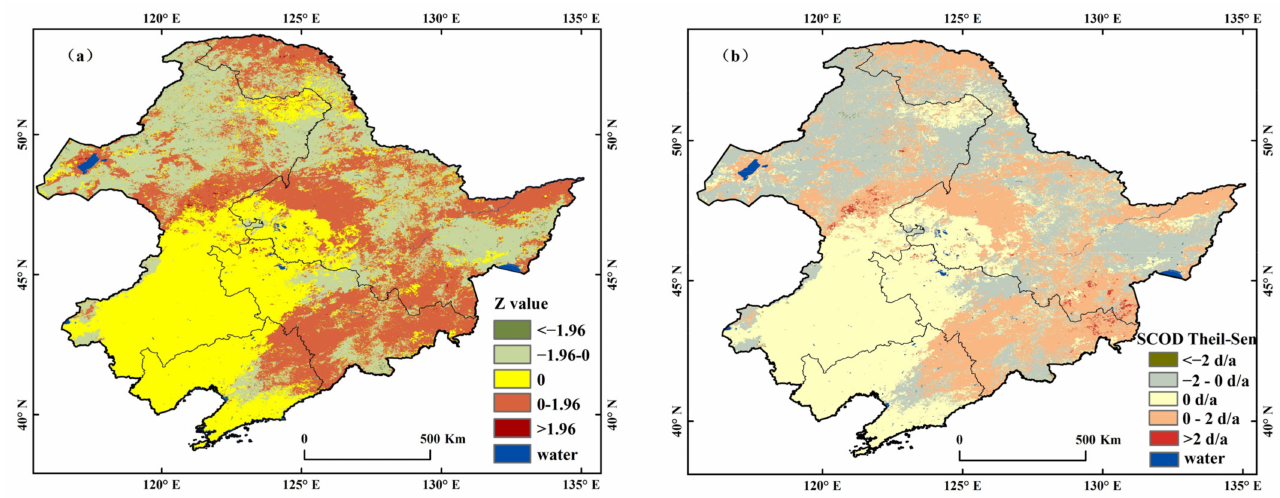
Figure 8. Trend of SCOD in Northeast China. ( a ) Significance test and ( b ) trend of SCOD from HY2001 to